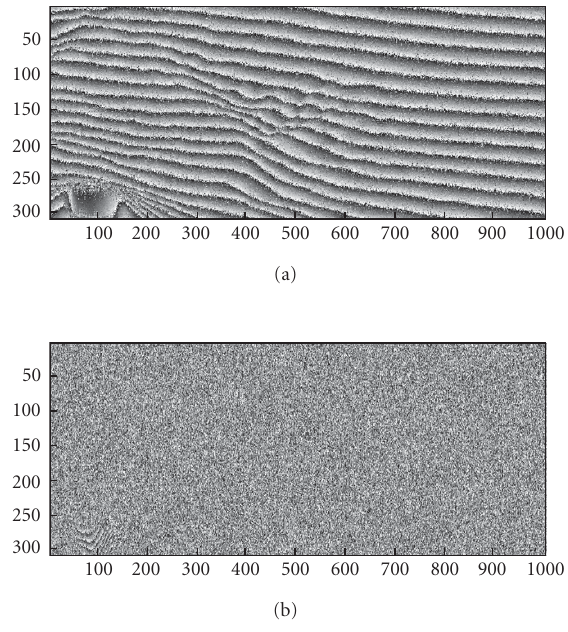
Figure 5: (a) Lowest and (b) highest baseline interferograms, 300 range pixels by 1000 azimuth pixels.